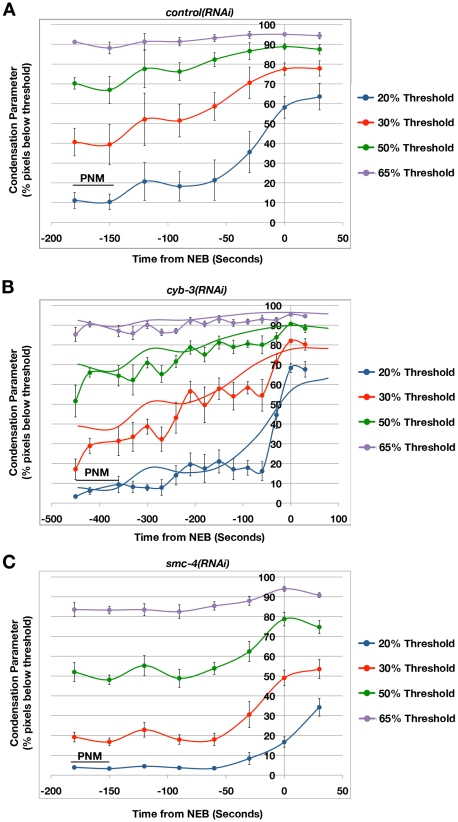
Mitotic chromosome condensation is delayed in cyb-3(RNAi) embryos.Embryos from TH32 (GFP::Histone H2B;GFP::γ-tubulin) hermaphrodites treated with A) control(RNAi), B) cyb-3(RNAi), or C) smc-4(RNAi) were subjected to live imaging. Condensation of the paternal pronucleus was measured as described in Materials and Methods. Condensation parameters (% pixels below threshold) are plotted for four thresholds (20, 35, 50, and 65%) with respect to time from NEB (t = 0) [87]. PNM: Pronuclear meeting. SMC-4-depleted embryos were used as a control for loss of condensin complexes and mitotic chromosome condensation [51]. The control(RNAi) results are overlaid on the cyb-3(RNAi) panel to assist in direct comparison. n =  embryos; control(RNAi), n = 6; cyb-3(RNAi), n = 7; smc-4(RNAi), n = 8; Error bars: SEM.